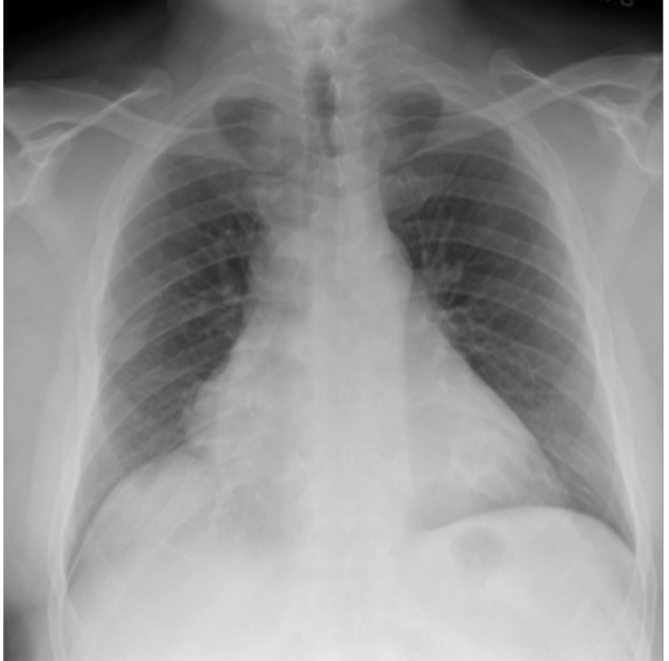
Image 1 . Chest radiograph of a 55-year-old male on hemodialysis who presented to the emergency department with fatigue.